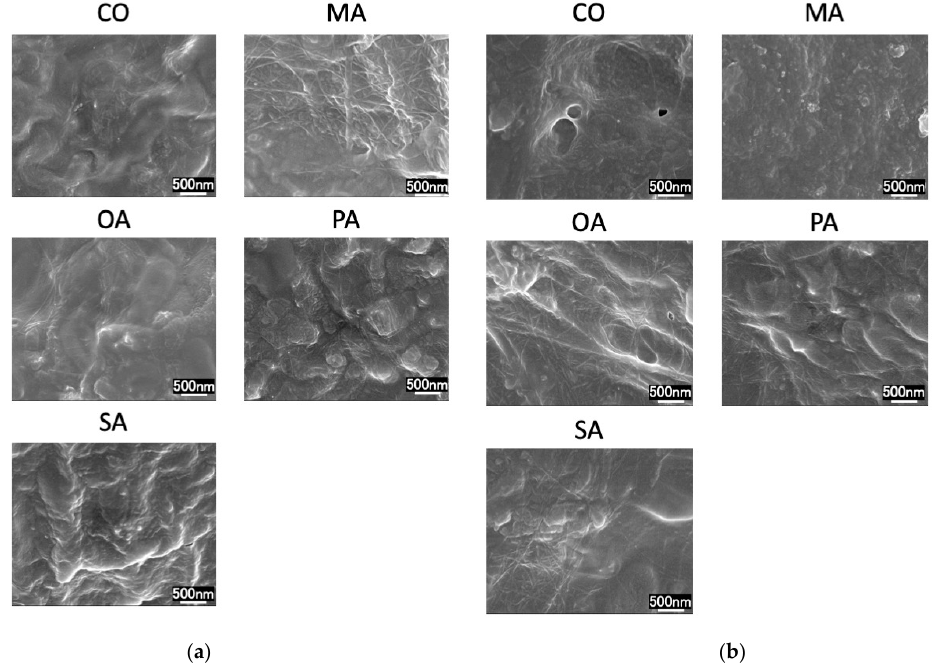
Figure 6. SEM images of each group after pH-cycling. ( a ) Deionized distilled water wash, ( b ) remineralization solution wash ( ×